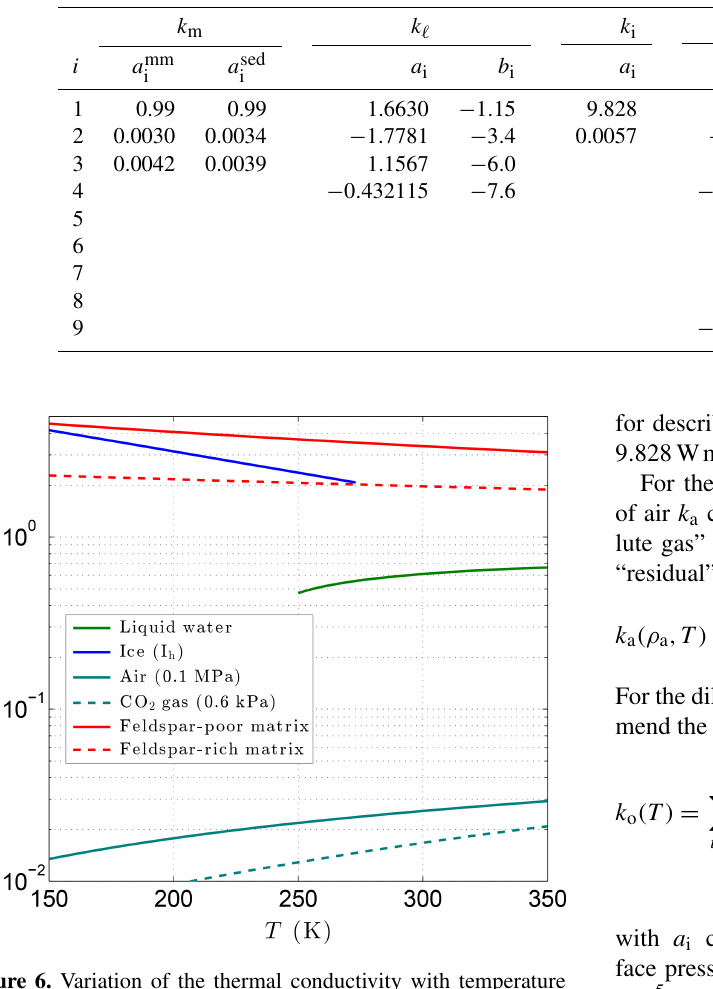
and a sed refer to the coefficients appropriate for magmatic/metamorphic and i i